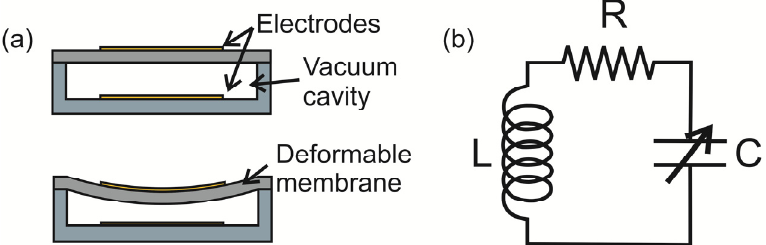
Figure 1. ( a ) Schematic of operation of a capacitive-based membrane pressure